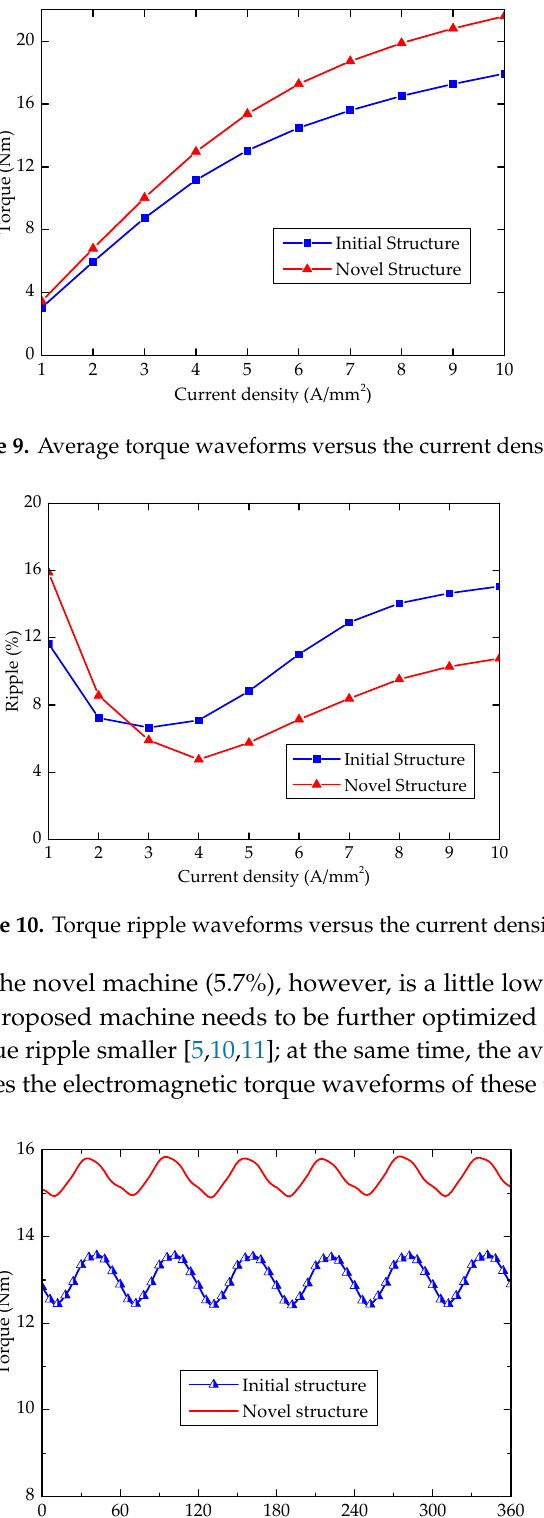
6 Figure 8. Fast Fourier transform (FFT) results of back ‐ EMFs of the two FSPM machines. After adding magnets in the dummy slots of the stator teeth, the amplitude of fundamental back ‐ EMFs is enhanced. It can be observed from Figure 8 that the third, fifth, and seventh components harmonics of on ‐ load back ‐ EMF are reduced greatly after adding magnets. Then, with magnets located in the dummy slots, the fundamental harmonic of on ‐ load back ‐ EMF is enhanced from 176.1 to 200.6 V. The total harmonic distribution (THD) of initial and proposed E ‐ shaped stator tooth machines is 5.7% and 4.7%, respectively, and there is no additional extra harmonic introduced into the targeted on ‐ load back ‐ EMF.